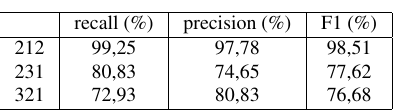
Table 4. North Macedonia: Evaluation metrics